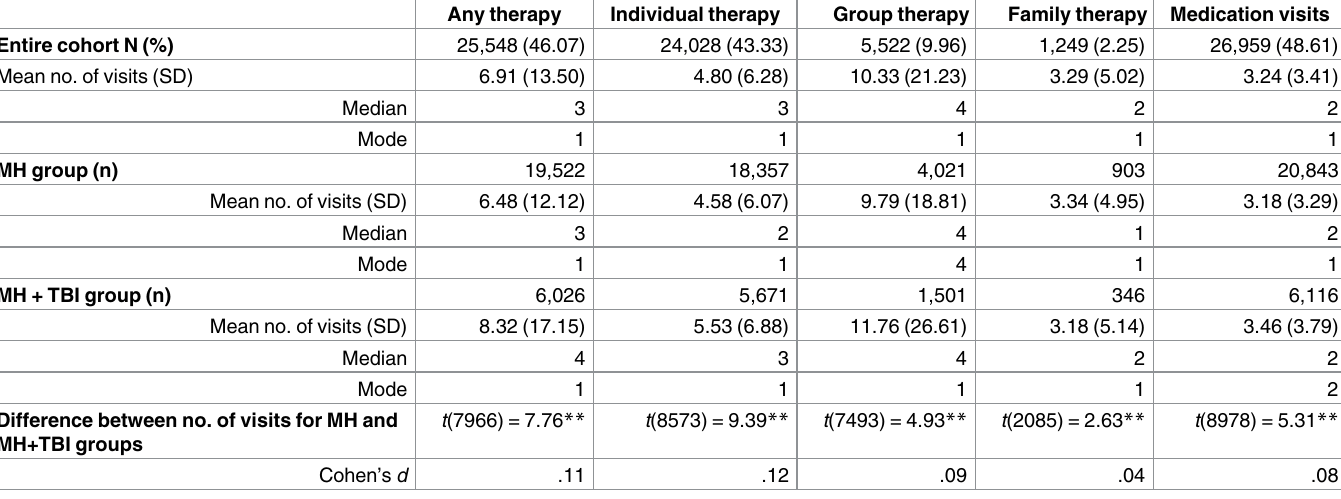
Table 2. Psychotherapy and medication visits at 12-months follow-up ( N = 55,458).